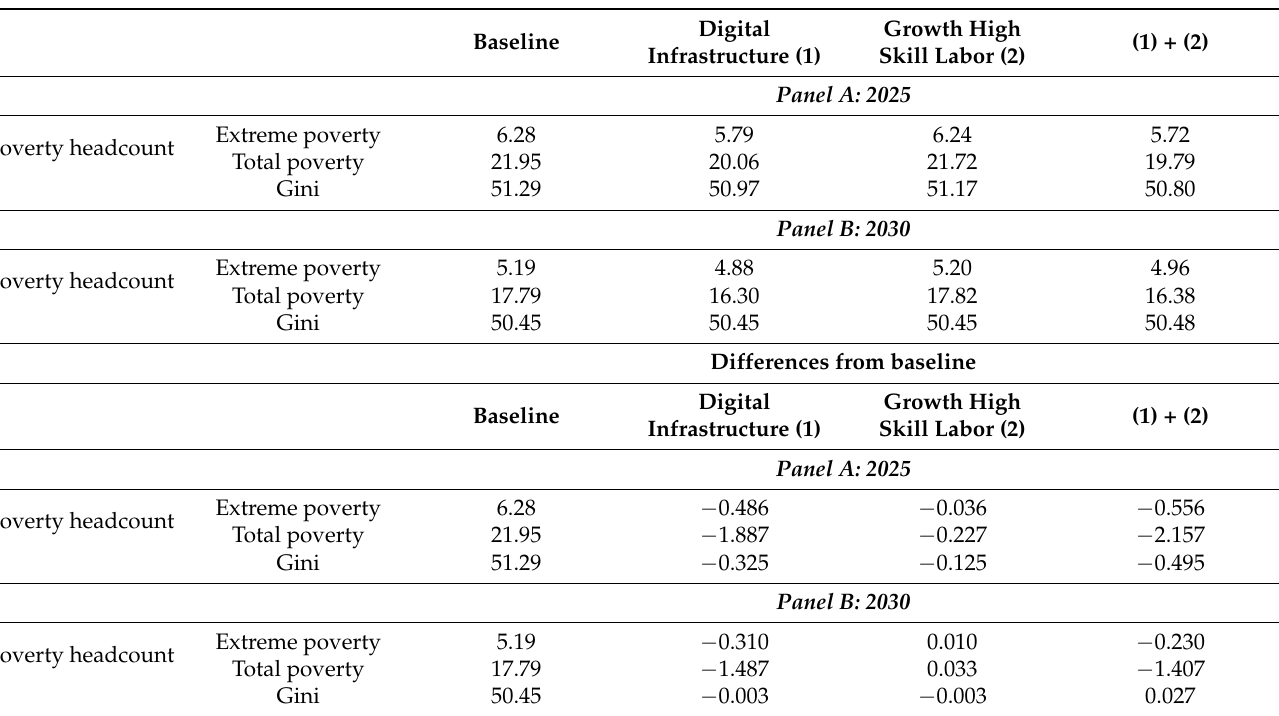
Table 10. Microsimulation impact on poverty and inequality digital infrastructure development (DID) reforms. Digital Growth Baseline Infrastructure (1)